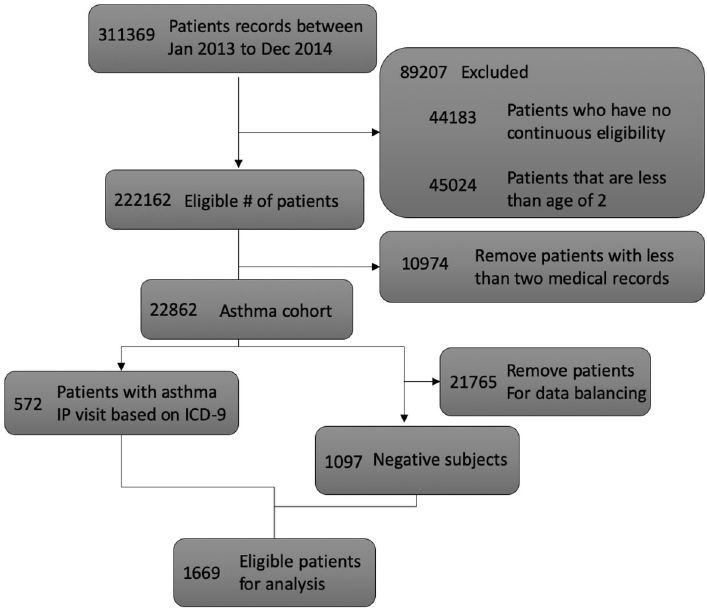
Figure 6. The cohort selection process for the study of asthma exacerbation.